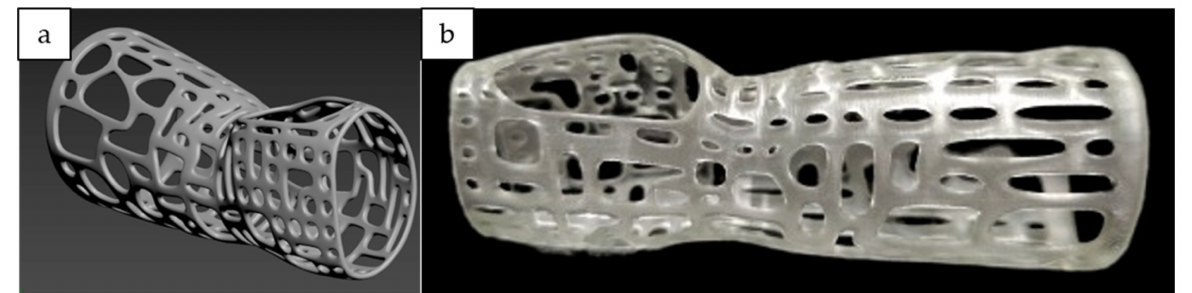
Figure 13. ( a ) The 3D model of cast; ( b ) 3D printed